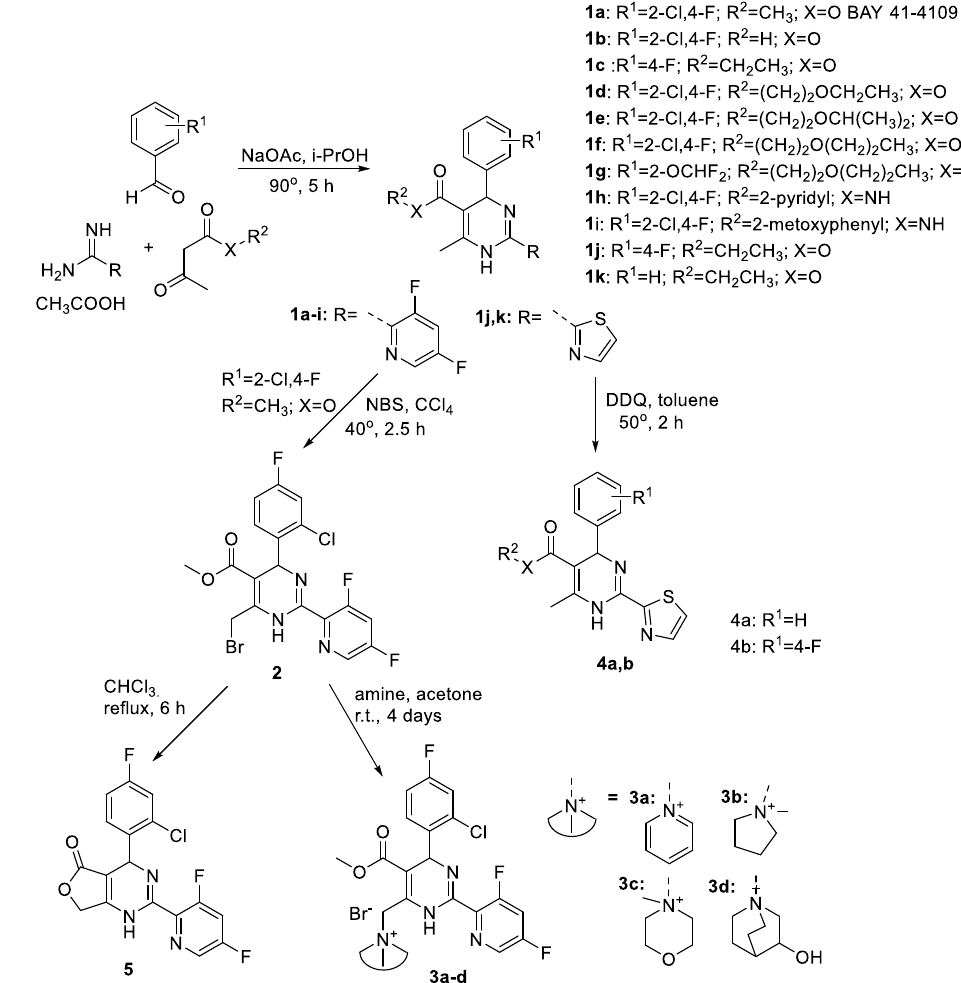
Figure 3. Synthesis of heteroaryldihydropyrimidine derivatives.